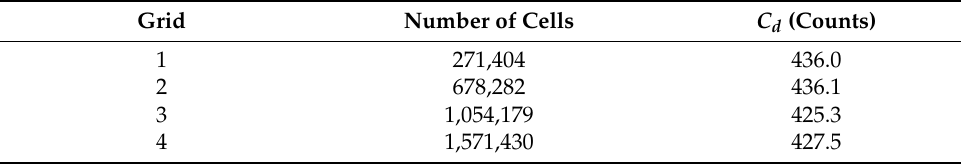
Table 2. Grid convergence study of aerodynamic performance for a 3-D